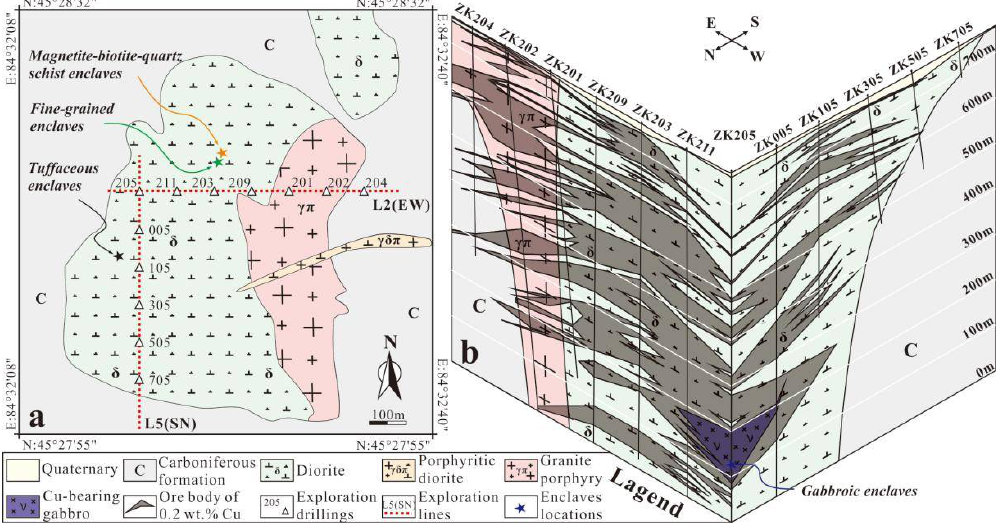
Figure 2. Geological map ( a ) and an EW–NS joint cross-section ( b ) of the Baogutu reduced Cu porphyry-type deposit (modified according to [7,20]).